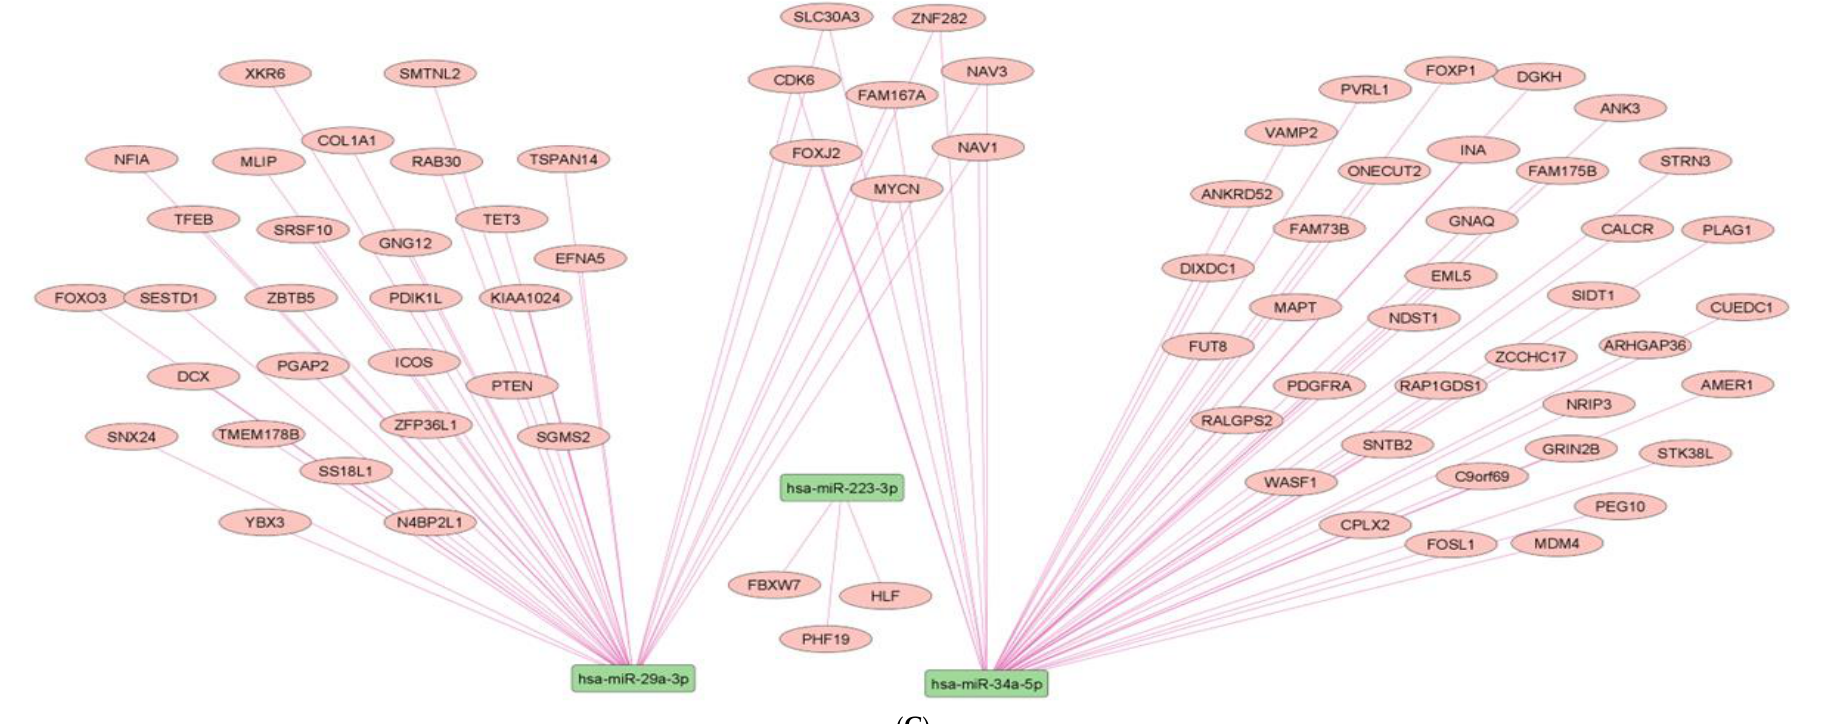
Figure 7. Common dysregulated miRNA – target networks in diabetes: ( A ) Human upregulated microRNA – gene target network: Topology of networks of commonly upregulated miRNAs in diabetes showing interaction network of functionally enriched miRNAs with their targets, with 305 nodes and 314 edges. The networks were constructed using Cytoscape 3.9.1 [84]. Using Mienturnet [85], the miRNA – target interactions were identified by TargetScan [86], and the functionally enriched miRNAs were generated using the KEGG database [87]. ( B ) Human downregulated microRNA – gene target network: Topology of networks of commonly downregulated miRNAs in diabetes showing interaction network of functionally enriched miRNAs with their targets, with 225 nodes and 231 edges. The networks were constructed using Cytoscape 3.9.1 [84]. Using Mienturnet [85], the miRNA – target interactions were identified by TargetScan [86], and the functionally enriched miRNAs were generated using the KEGG database [87]. ( C ) Human upregulated and downregulated microRNA – gene target network: Topology of networks of commonly upregulated and downregulated miRNAs in diabetes showing interaction network of functionally enriched miRNAs with their targets, with 79 nodes and 84 edges. The networks were constructed using Cytoscape 3.9.1 [84]. Using Mienturnet [85], the miRNA – target interactions were identified by TargetScan [86], and the functionally enriched miRNAs were generated using the KEGG database [87].